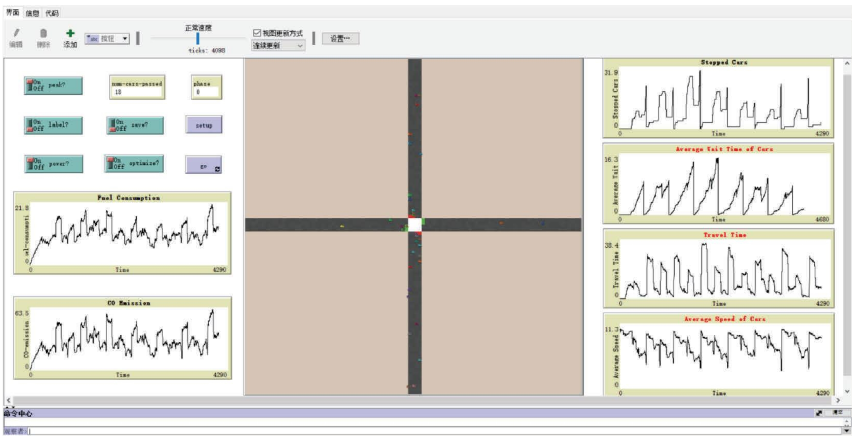
Figure 7: Schematic diagram of the simulation interface of the experimental Table 1: Te trafc volumes statistics of the intersection (pcu/h).